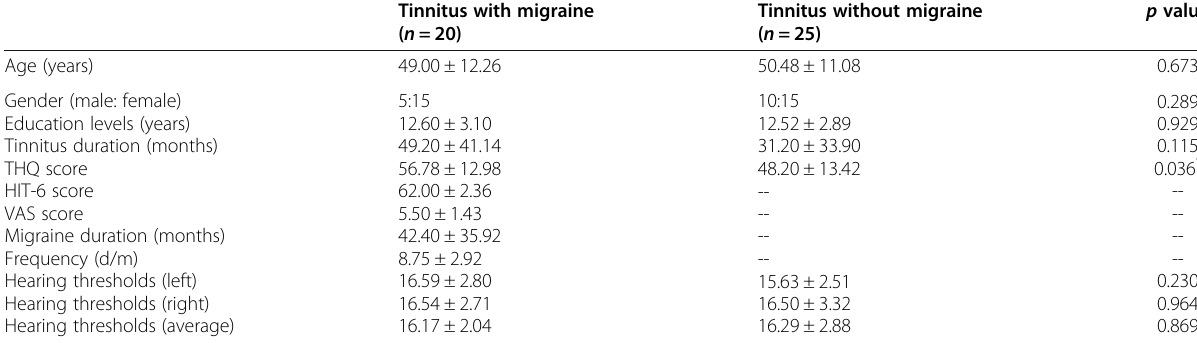
Table 2 Demographic and clinical characteristics of tinnitus patients with and without migraine